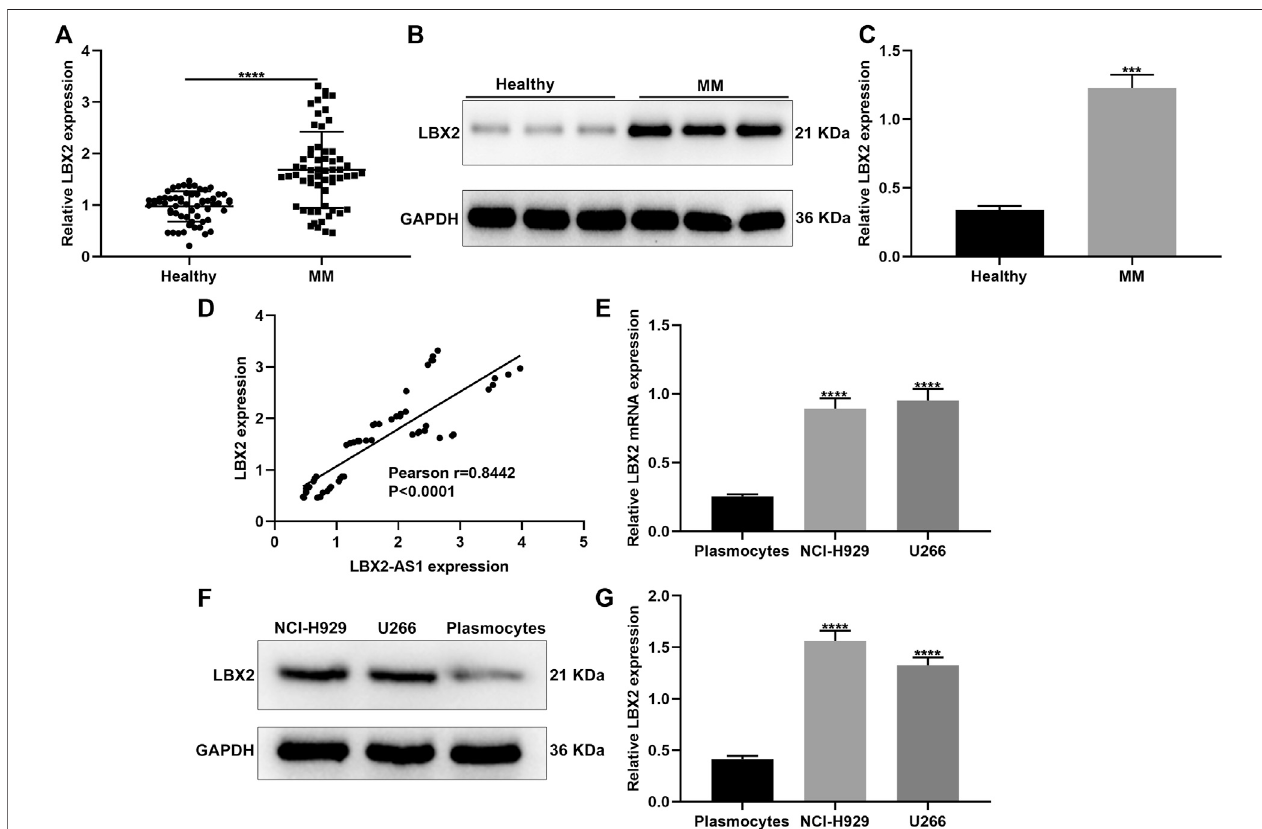
FIGURE4| LBX2isup-regulatedinserumsamplesofMMandhasapositivecorrelationtoLBX2-AS1. (A) RT-qPCRforLBX2mRNAexpressioninserumsamples from60pairedMMandhealthysubjects. (B,C) LBX2proteinexpressioninserumsamplesfromMMandhealthysubjects. (D) CorrelationbetweenLBX2-AS1andLBX2 expression in60MMpatients. (E) ThemRNAaswellas (F,G) proteinexpressionofLBX2-AS1inCD138+plasmocytes,NCI-H929andU266cells.*** p < 0.001;**** p < 0.0001.